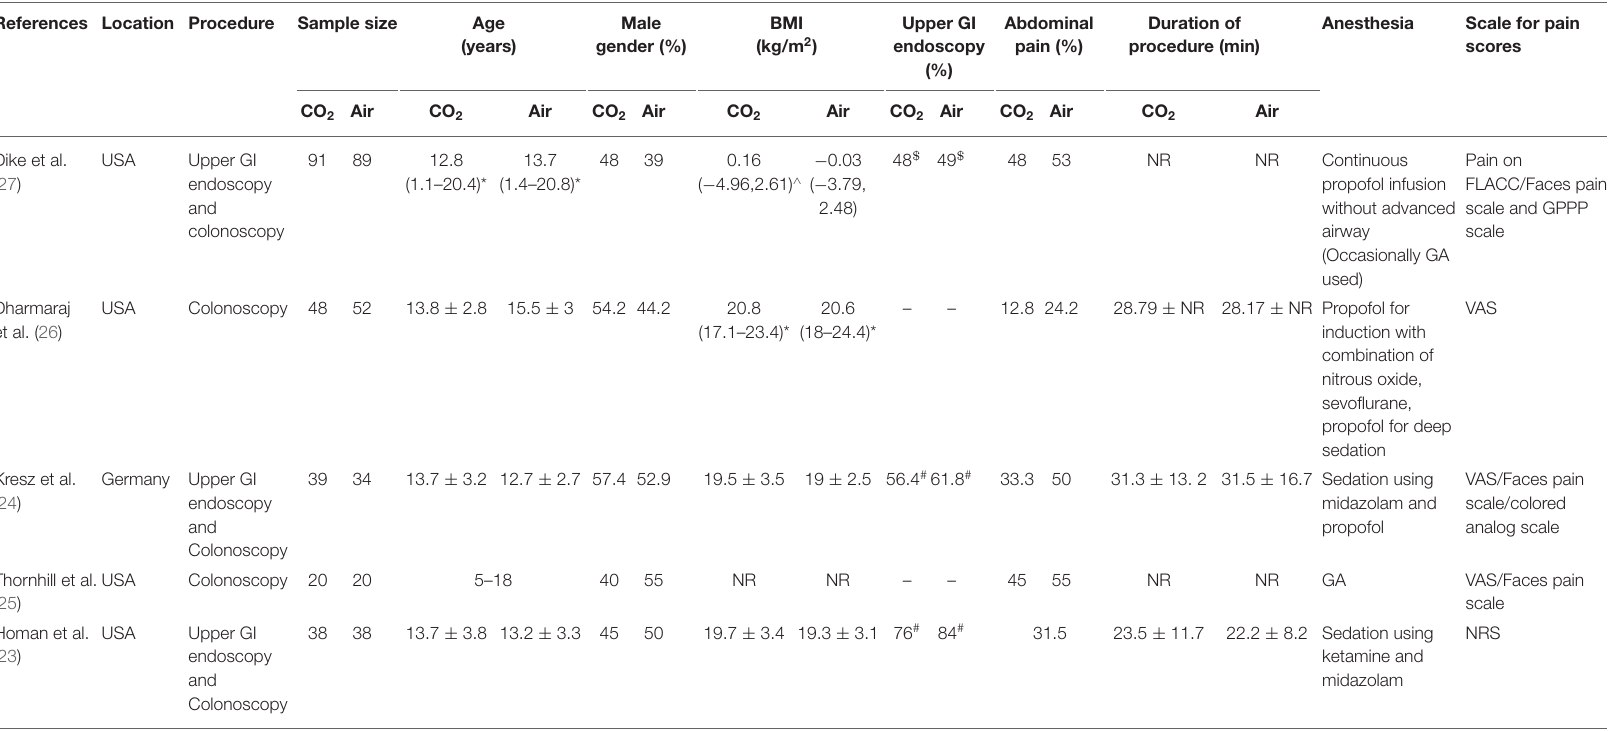
TABLE 1 | Details of included